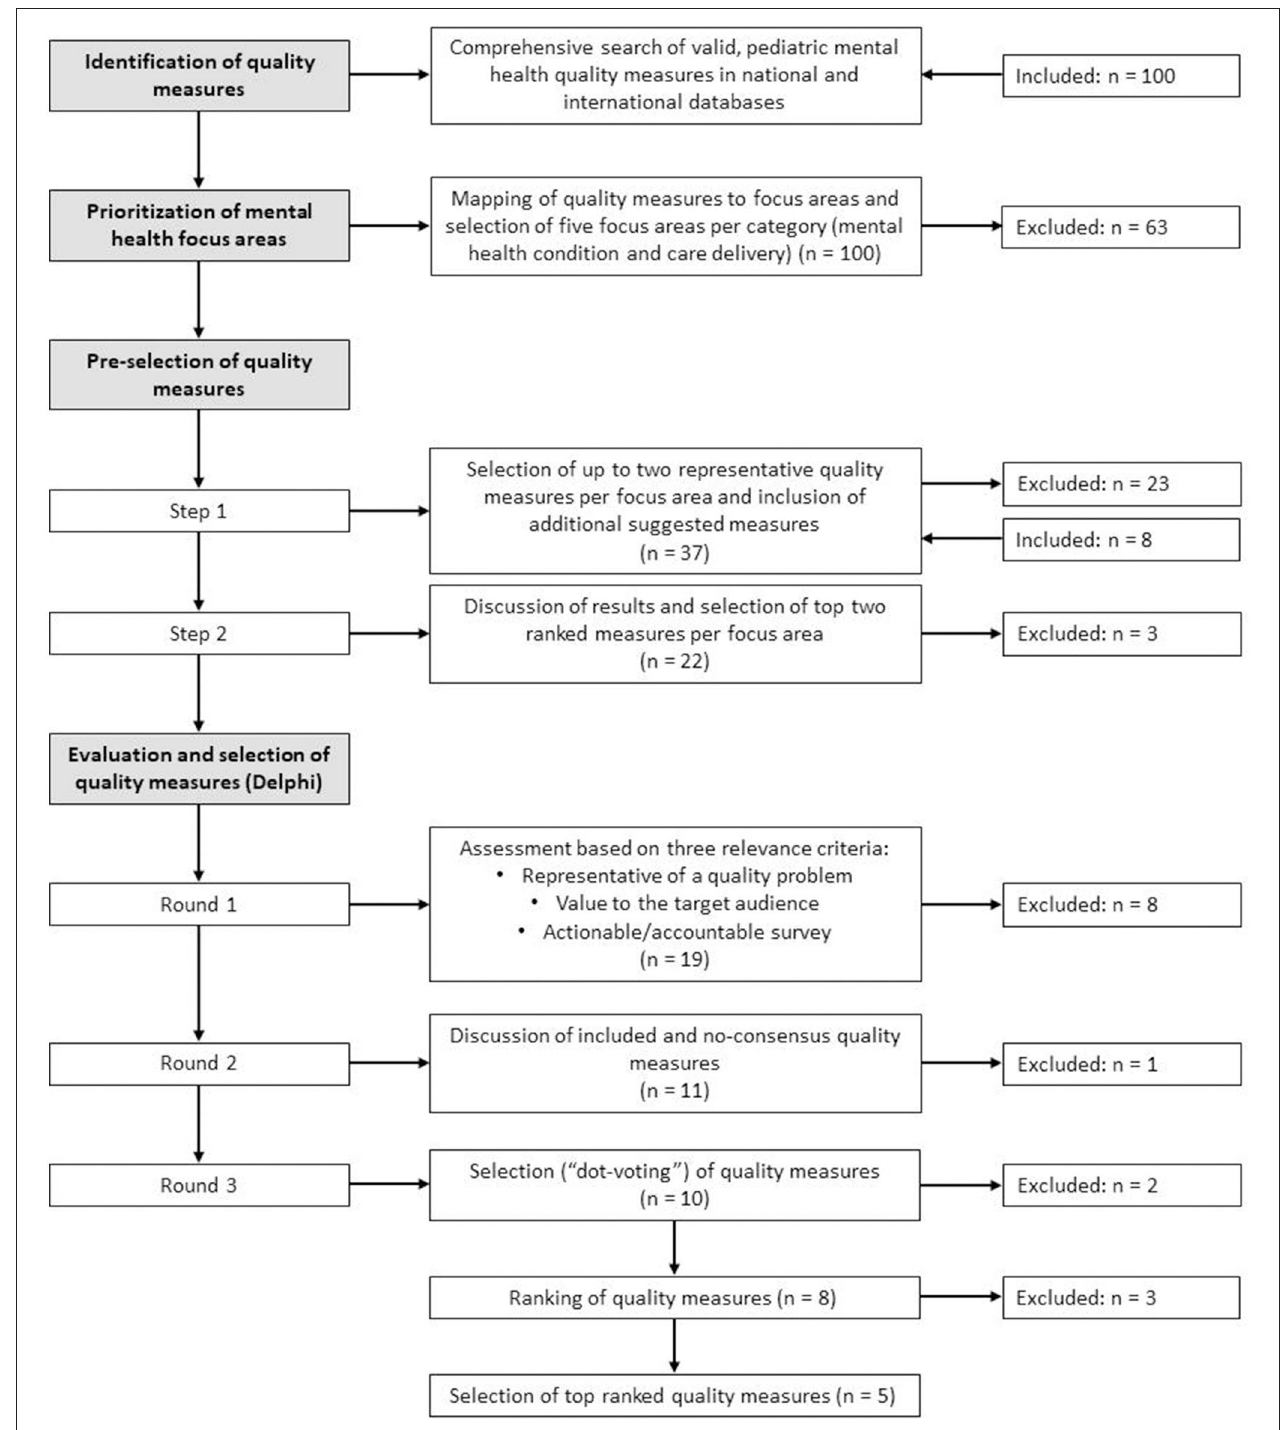
FIGURE 1 | Flow chart of the different study phases.